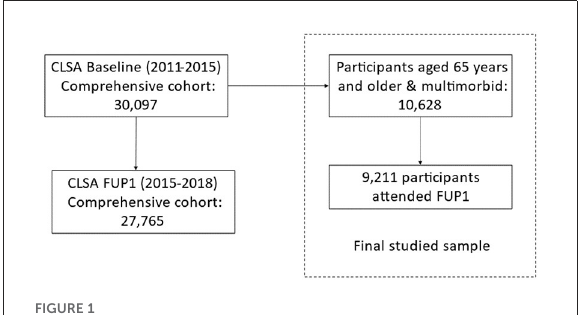
FIGURE1 Flow chart of CLSA sample